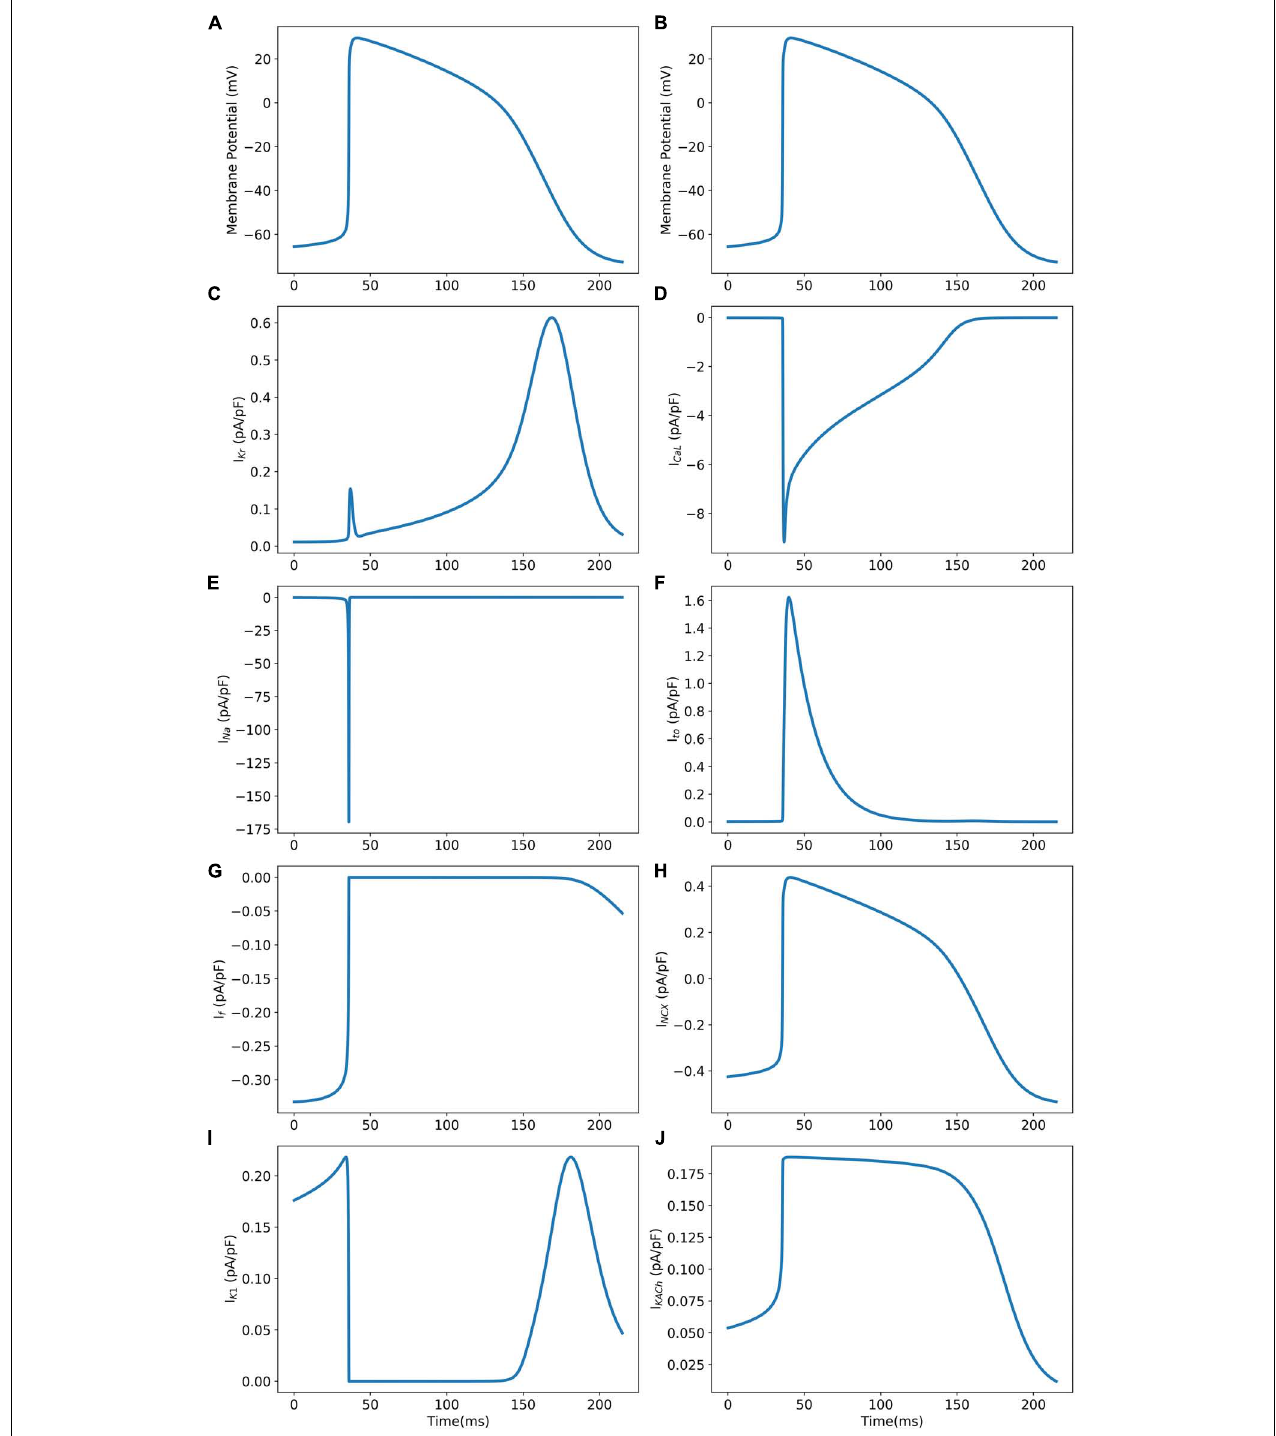
Figure 12A shows the model behavior in hyperkalemic conditions. Our model showed an increased spontaneous firing rate and diastolic depolarization when extracellular K + was